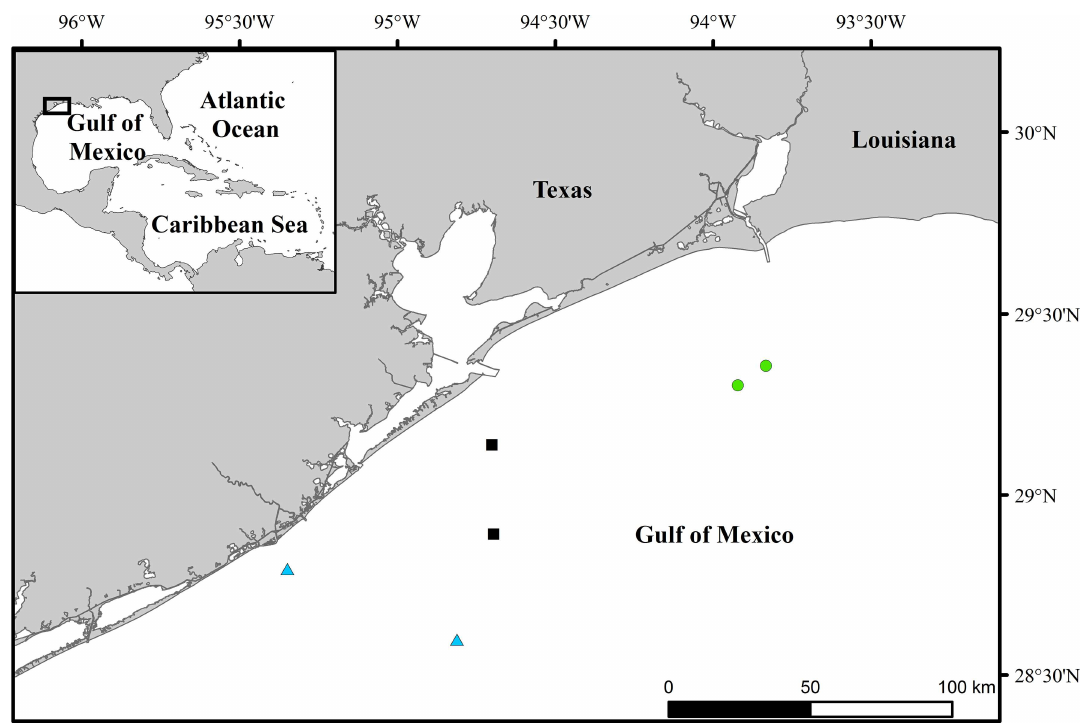
Fig 1. Location of study sites off the texas coast in the northwest Gulf of Mexico. Reefs were grouped into three regions, east (green circles), central (black squares) and west (blue